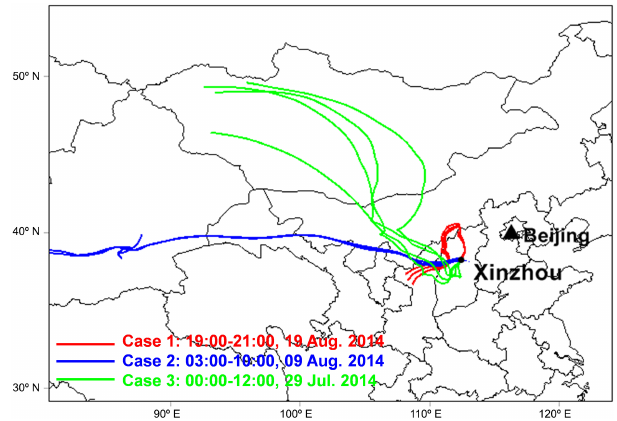
Figure 3. Five-day back trajectories for Case 1 (in red), Case 2 (in blue), and Case 3 (in green) calculated using the Hybrid Single- Particle Lagrangian Integrated Trajectory model with National Cen- ters for Environmental Prediction reanalysis data. The arrival height of the trajectories at the Xinzhou site was at the